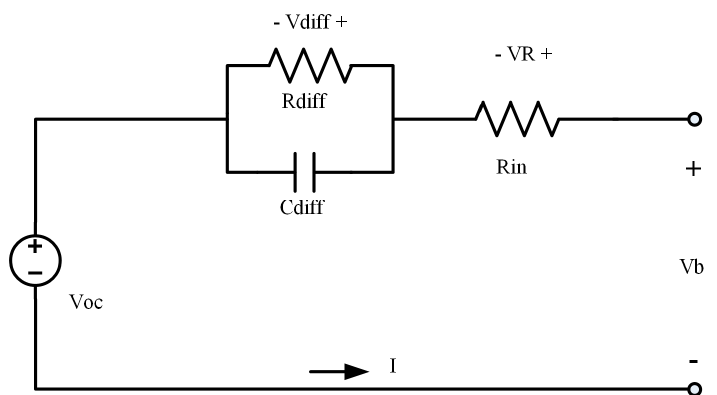
Figure 5. Battery equivalent circuit model.